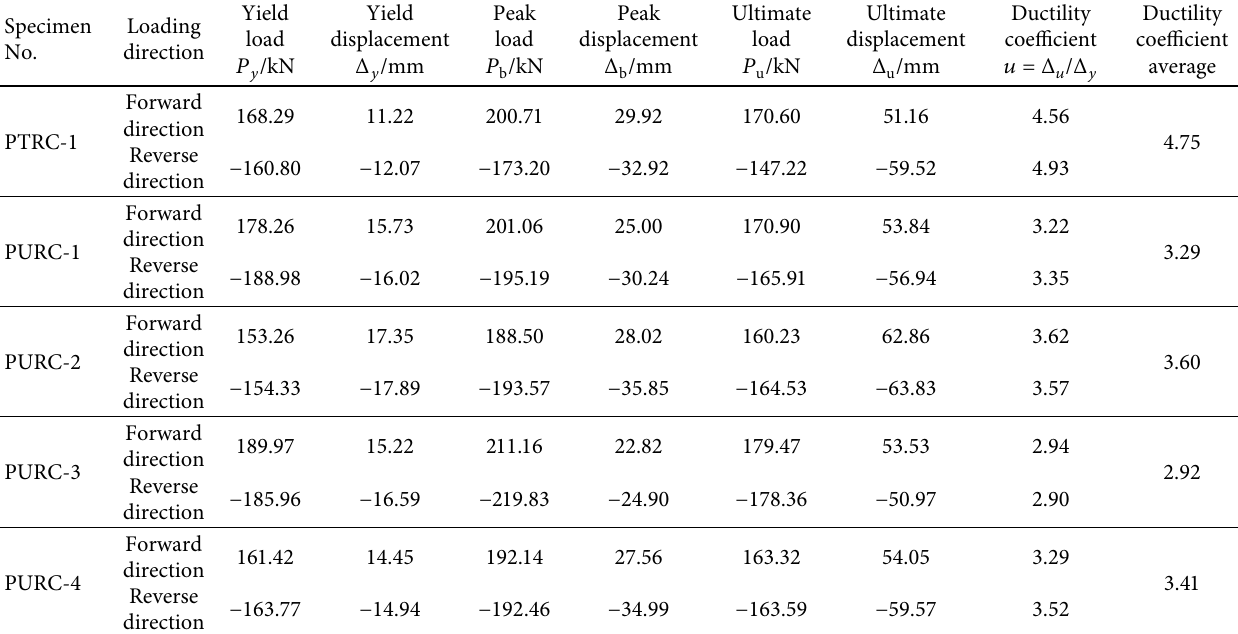
Table 4: Ductility coefficients of the